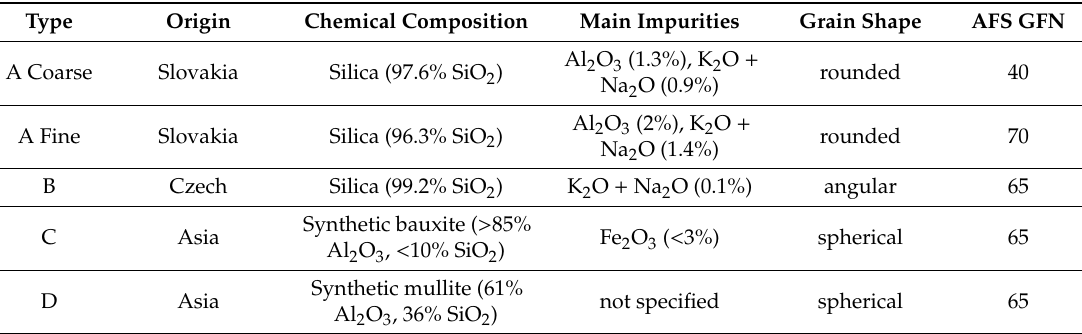
Table 1. List of tested sands. GFN, grain fineness